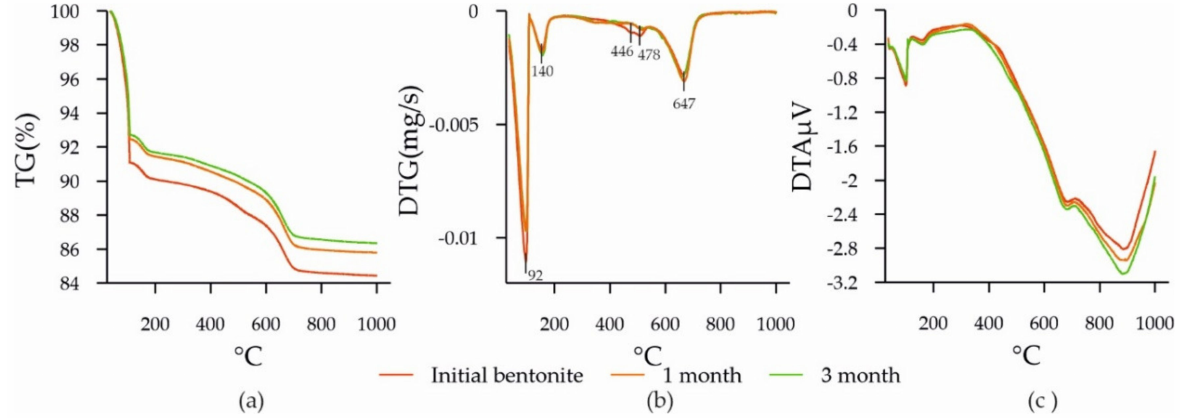
Figure 9. Graphs of thermal analysis of bentonites: ( a ) TG; ( b ) DTG, ( c ) DTA. Endothermic effects in the regions of 446 and 478 ◦ C traced in the original bentonite decreased in the bentonites after 1 and 3 months of the experimental exposure